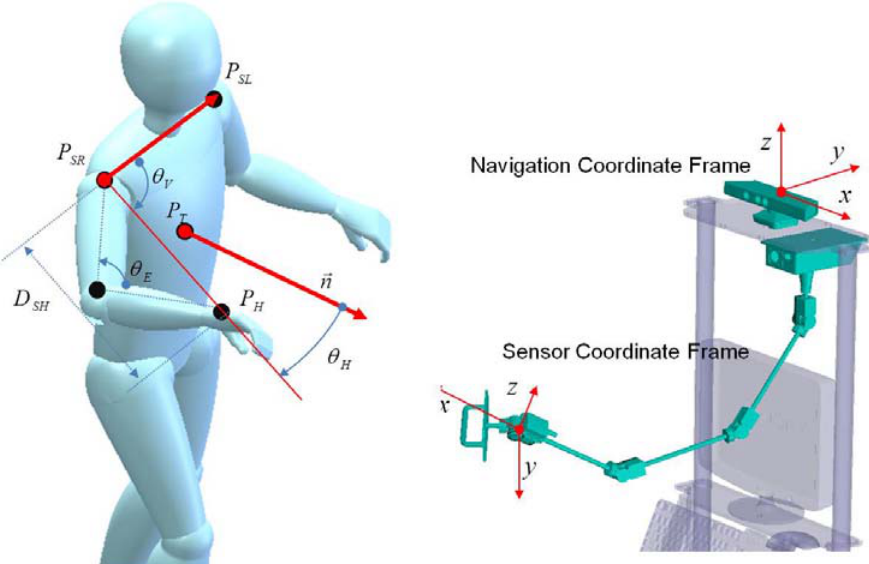
Figure 6. Frames, angles and distance